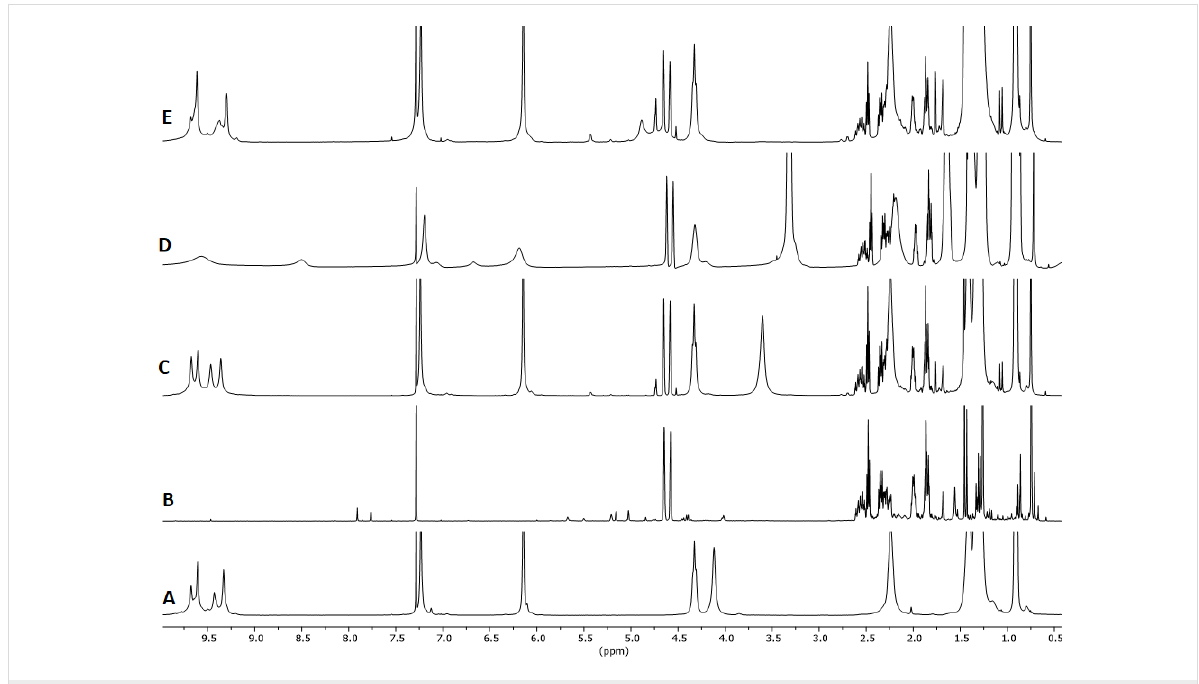
Figure 5: 1 H NMR spectra in water-saturated CDCl 3 , except for E. A: [ 1 6 ] (7.5 mM); B: β -pinene; C: β -pinene (75 mM), [ 1 6 ] (7.5 mM); D: β -pinene (75 mM), [ 1 6 ] (7.5 mM), Bu 4 NBr ( 3 , 78 mM); E: β -pinene (75 mM), [ 1 6 . 8H 2 O] (7.5 mM). Spectra recorded after 64 h at room temperature, while A and B were recorder right after sample preparation.